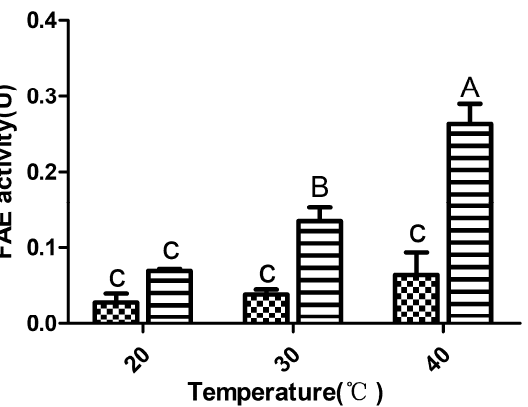
Figure 2. The Flieg’s point of sorghum silage. Control ; LF18, Lactobacillus farciminis inoculant ; LP23, Lactobacillus plantarum inoculant . Means within the same temperature (a, b) or ; LP23, within the same inoculant (A, B) with difference superscripts differ significantly from each other ( p < 0.05). Error bars indicate standard error of means.